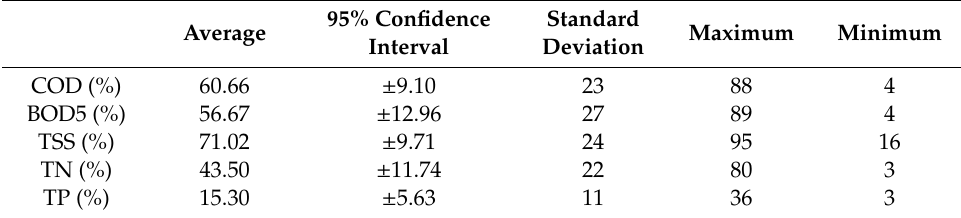
Table 3. Statistics of accumulated removal e ffi ciencies for the HUSB.